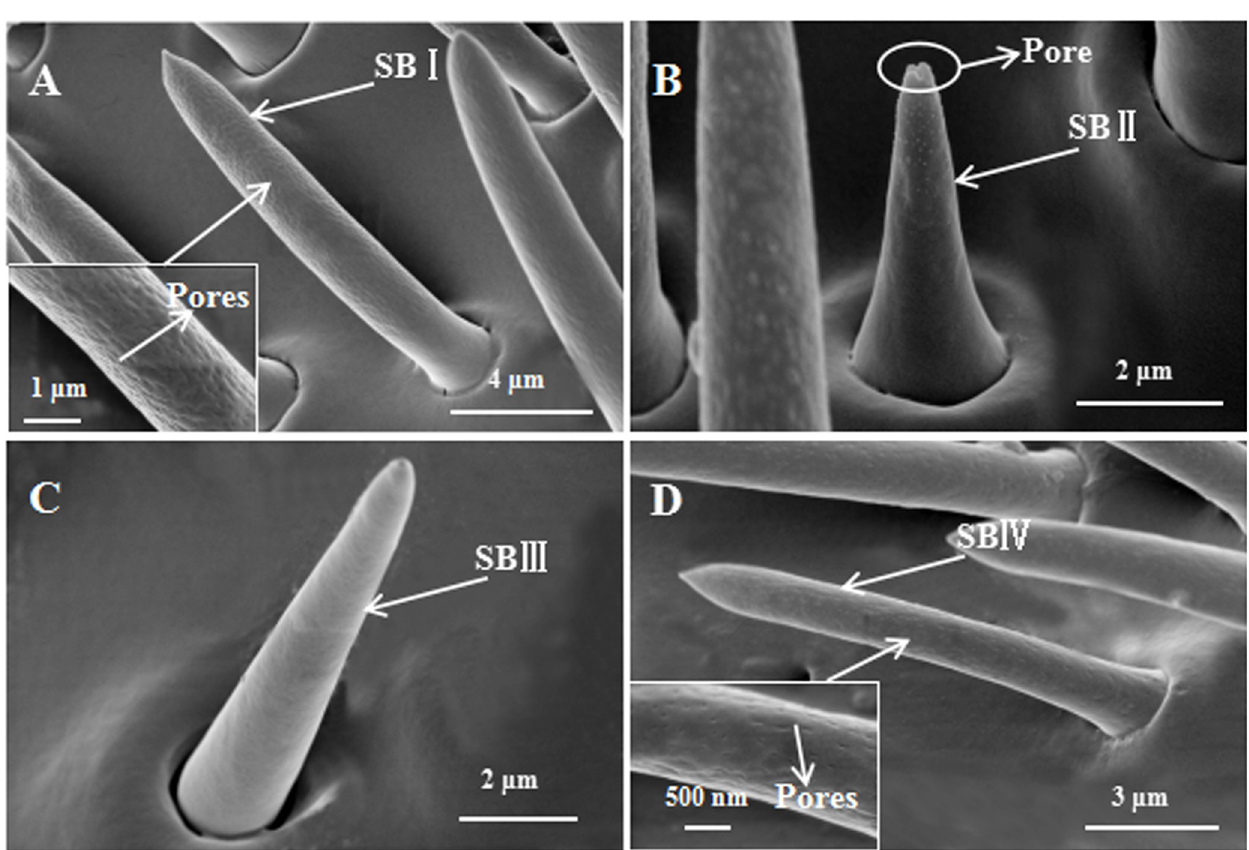
Fig 4. Scanning electron micrographs of SB external cuticular structures on Euplatypus parallelu antennae. A: SBI. Inset: The high magnification picture of SBI. B: SBII. C: SBIII. D: SBIV. Inset: The high magnification picture of SBIV.